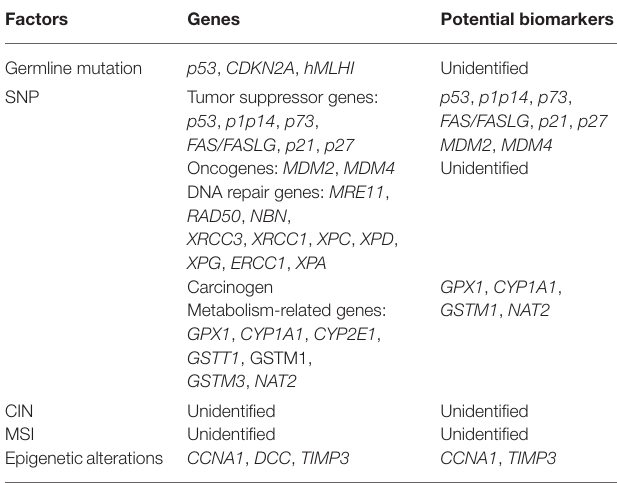
TABLE 1 | Genetic factors, genes, and potential biomarkers of multiple primary cancer of HNSCC. Factors Genes Potential